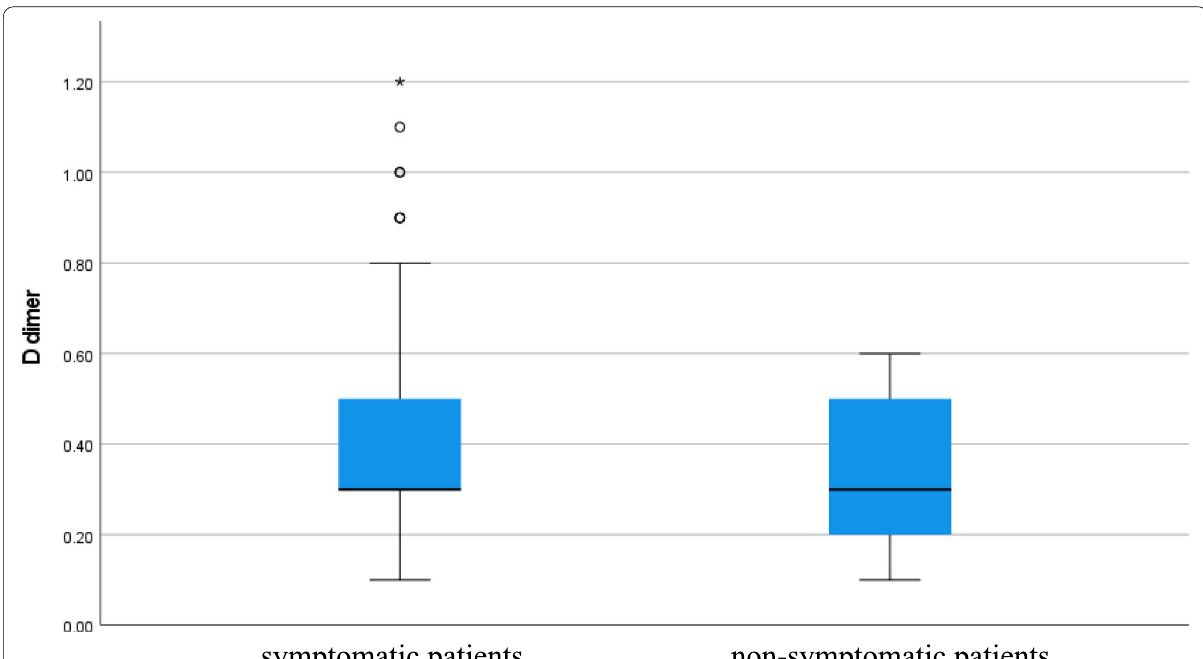
Fig. 7 Serum D-dimer level of COVID 19 patients (symptomatic and n0n-symptomatic)